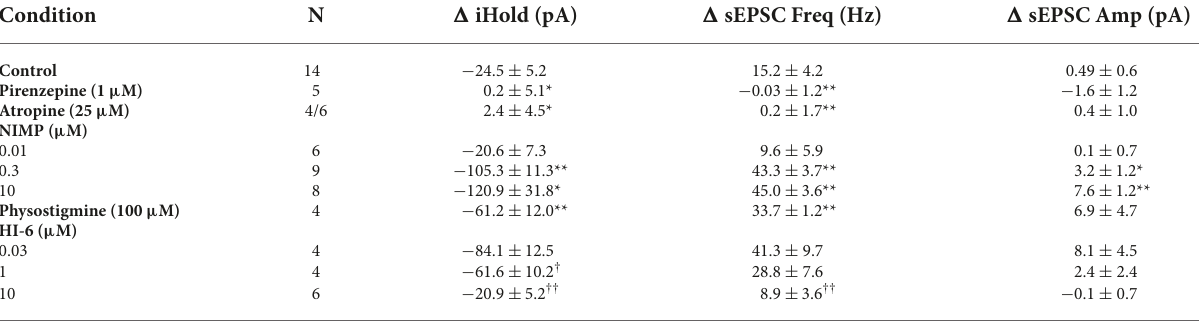
TABLE 1 Summary of ACh-induced changes in holding current, sEPSC frequency, and sEPSC amplitude across multiple